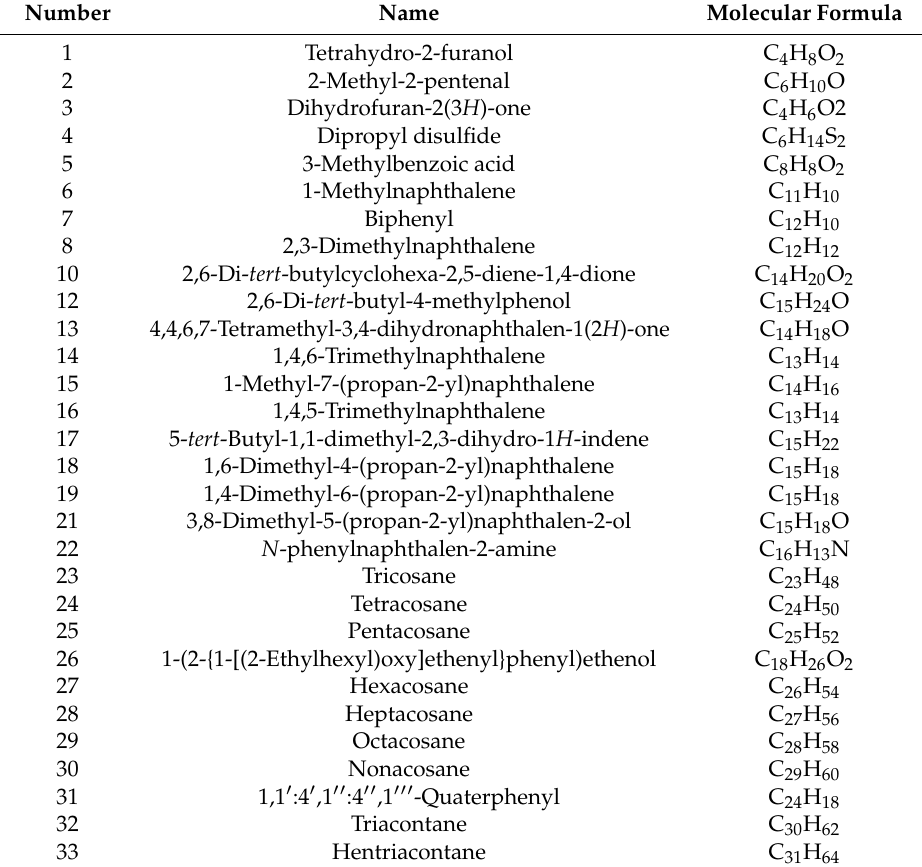
Table 4. CFH tetrahydrofuran extraction GC/MS analysis